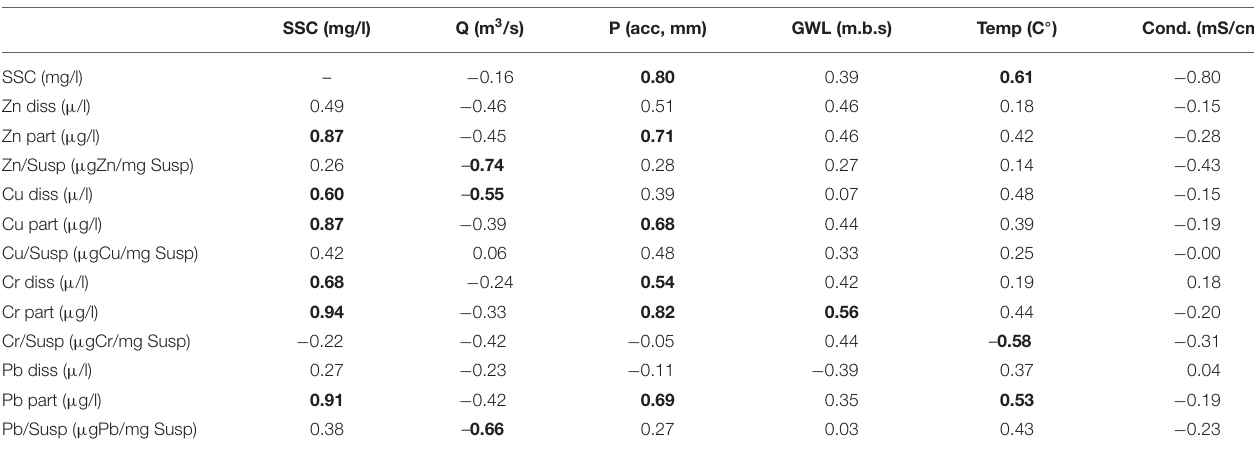
TABLE 3 | Correlation between metal concentrations and physical